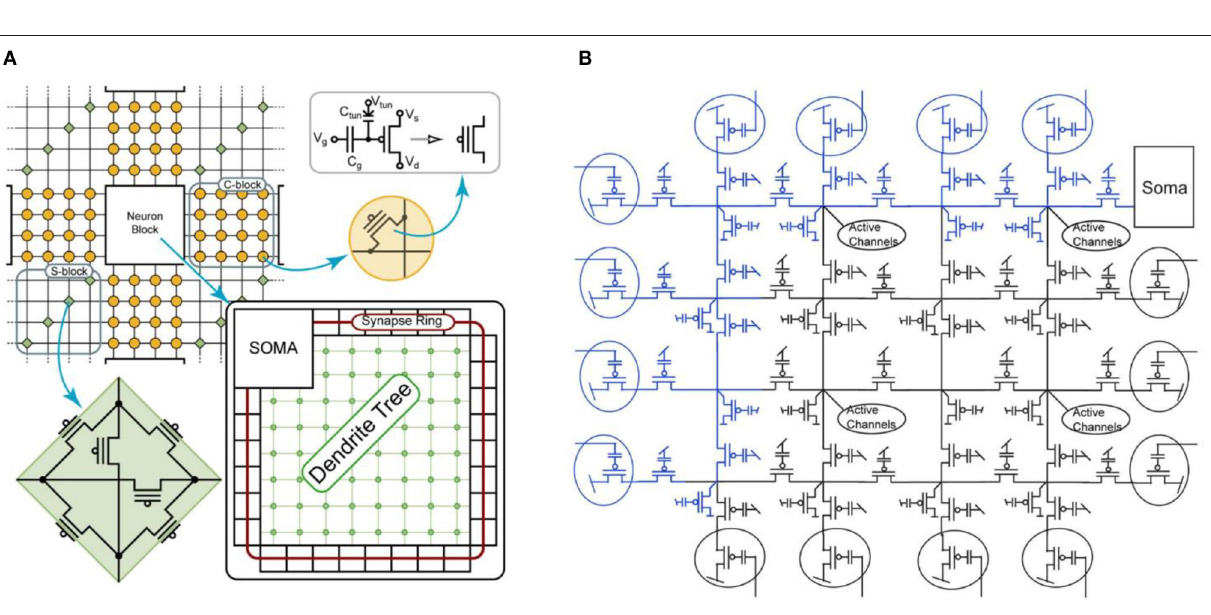
FIGURE 28 | Neuron IC embedded in a typical FPAA/FPGA routing fabric. (A) The Neuron I/O interface with the routing at the C-Blocks through programmable floating-gate switches. The tracks are segmented for allowing faster event transmission and maximizing utilization. The tracks are routed at the S-Blocks, where each node consists of six switches. The neuron cell has synaptic inputs, programmable dendrites with active channels that aggregate inputs into the soma block. (B) Depiction of the neuron cell structure, with arbitrary dendritic structure capability. Dendrites are also interspersed with active channels to model the nonlinear behavior observed in biology. An 8-tap dendritic line programmed on the neuron is shown in blue